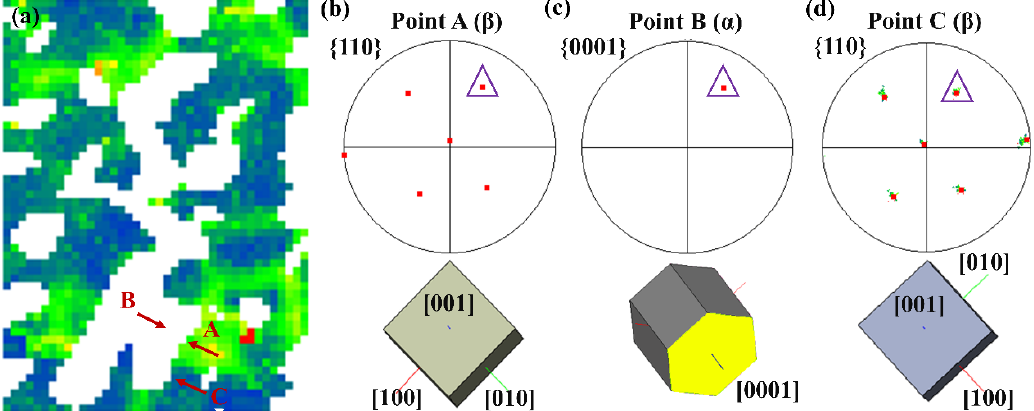
Figure 7. ( a ) The KAM values map of the β phase in local areas circled in Figure 4a; ( b ) the {110} β pole figure at arrow A; ( c ) the {0001} α pole figure at arrow B; ( d ) the {110} β pole figure at arrow C.